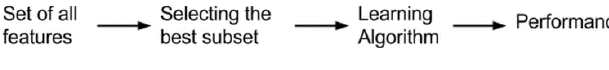
Figure 3 . Filter Methods